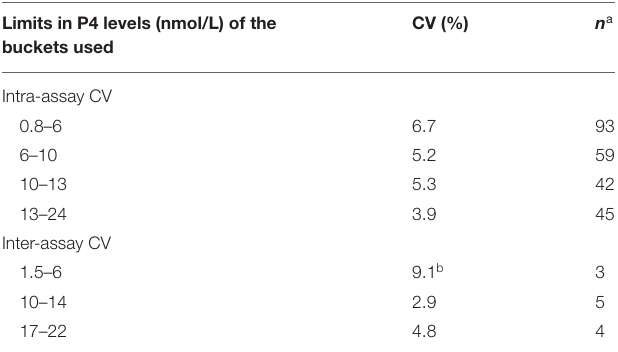
TABLE 3 | Intra- and inter-assay coefficients of variation for the IMMULITE progesterone assay. Limits in P4 levels (nmol/L) of the buckets used